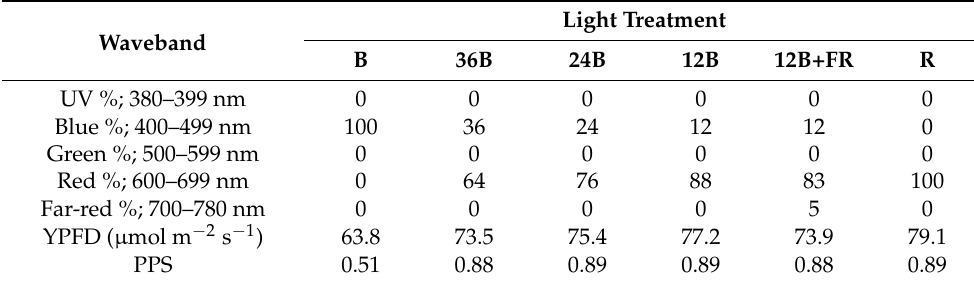
Table 1. Wavelength distribution and important photobiological parameters of the light treatments tested. YPFD: yield photon flux density; PPS: phytochrome photostationary state. YPFD and PPS values were calculated according to Sager et al.